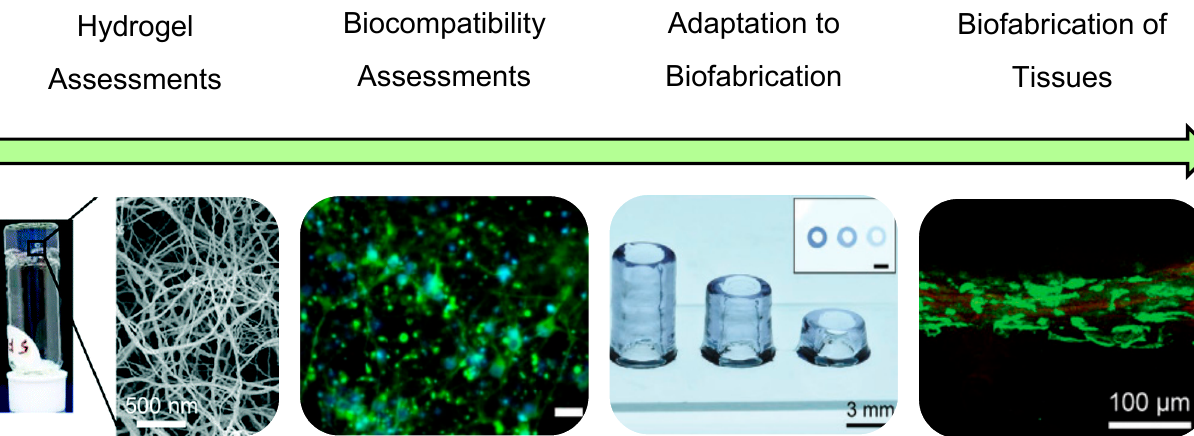
Figure 1. The road to biofabrication with peptide-based materials involves the discovery of self-assembling peptides that form hydrogels with ECM-mimetic properties. The materials undertake assessment to determine biocompatibility with a range of cell types as seen here with cortical neurons. Furthermore, the adaptation of hydrogel mechanical properties and the development of unique biofabrication strategies for peptide–biomaterials are developed, enabling high shape fidelity and the precise deposition of biocompatible peptide–biomaterials. The emergence of cell laden peptide-biomaterials which can be biofabricated demonstrates the successful translation of peptide materials to the biofabrication of tissues. Images adapted with permission from Rauf et al. 2021 CC BY-NC 3.0 published by RCS [80], Susapto et al. 2021 Copyright ACS [81] and Sather et al. 2021 Copyright Wiley-VCH